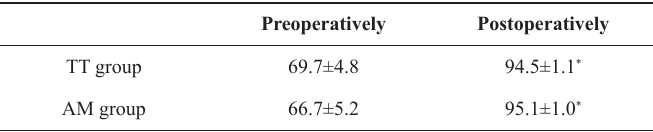
TABLE 1 - Lysholm scores before and after ACL reconstruction in both groups.